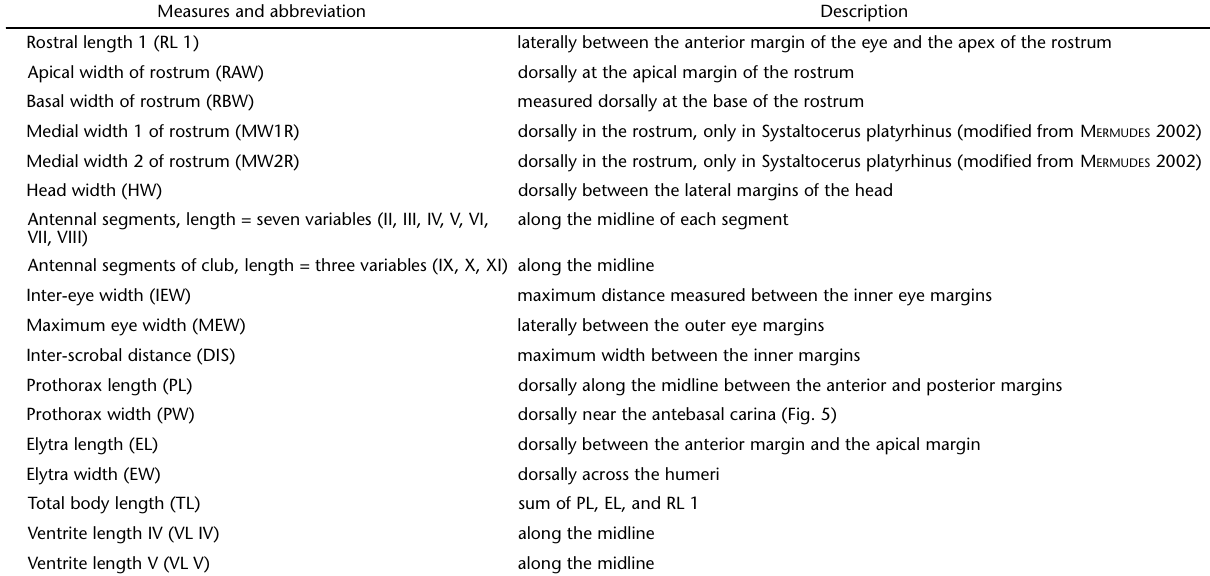
Table I. Measurements obtained from each part of the body.